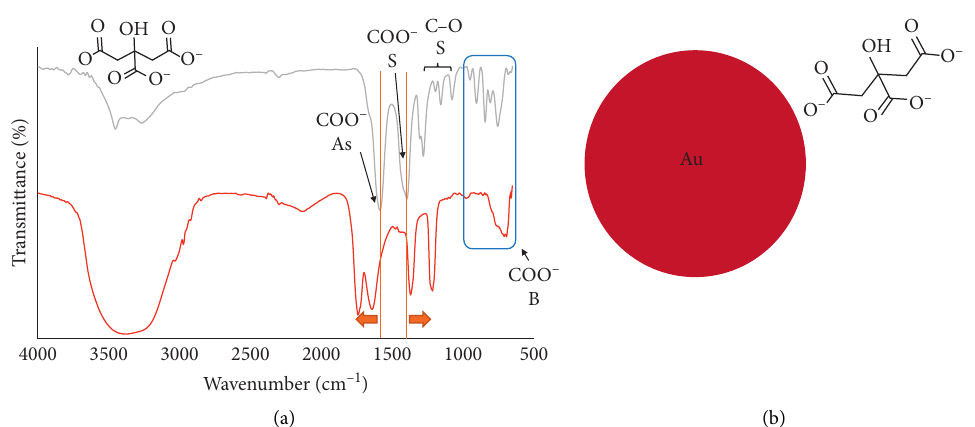
Figure 6: (a) FTIR spectra of Cit-HAuNPs suspension and Na-Cit solution and (b) proposed schematic of unidentate coordination of the